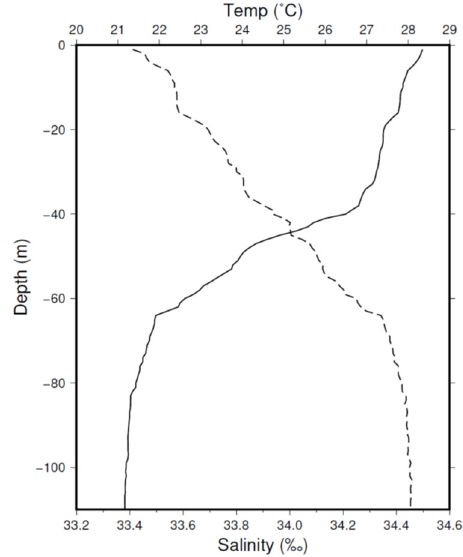
Figure 9. Observed temperature (solid line) and salinity (dashed line) profiles derived from the CTD sampling casts at 119.8511° E, 23.6373° N of the R/V Researcher Vessel No. 3 were imposed as the model’s initial conditions. The station location is denoted by a star mark in Figure 1a.